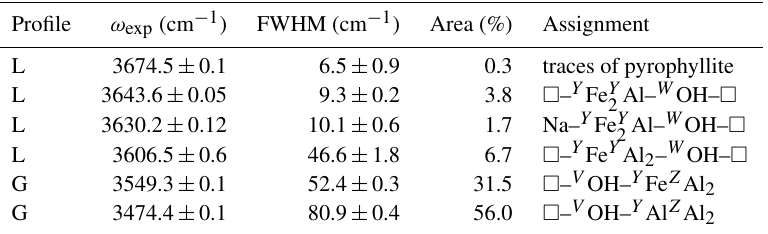
Table 1. Profile function, frequency ( ω exp ), full width at half maximum (FWHM) and relative area of OH-stretching bands in the LH12 sample (Fig. 2).